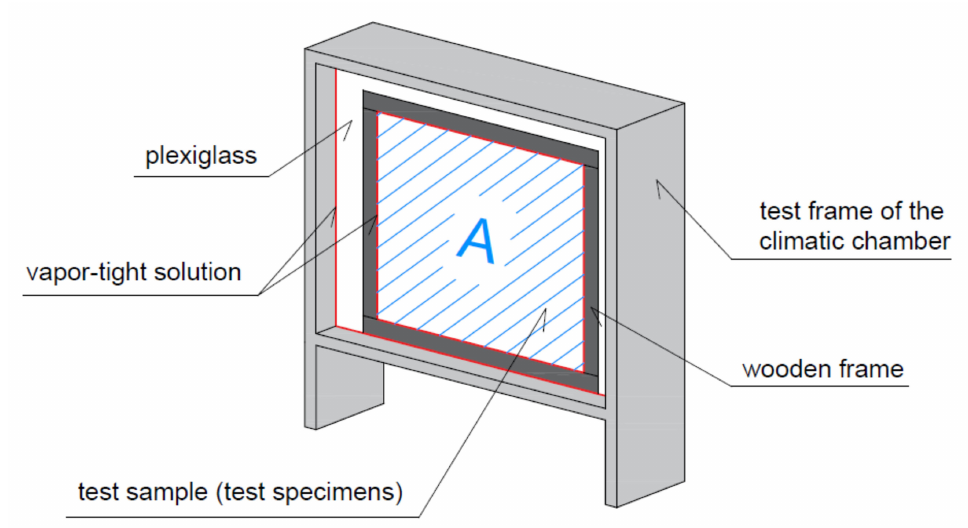
Figure 3. Vapour-tight solution: attaching the test specimen to the test